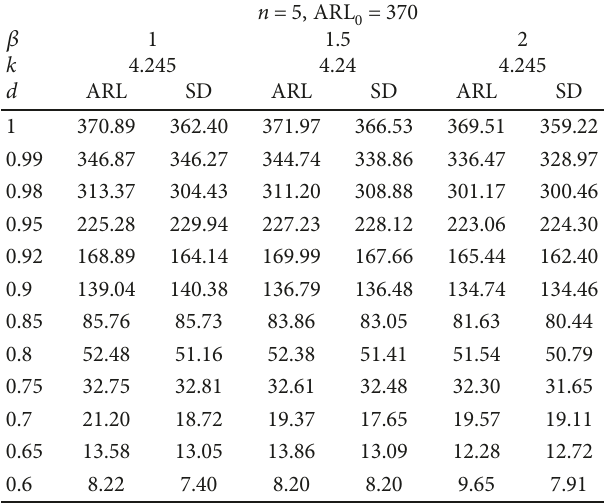
Table 3: The values of ARLs when q = 0 95 , α = 1 0 , θ = 50 , and β = 1 0,1 5,2 0 .